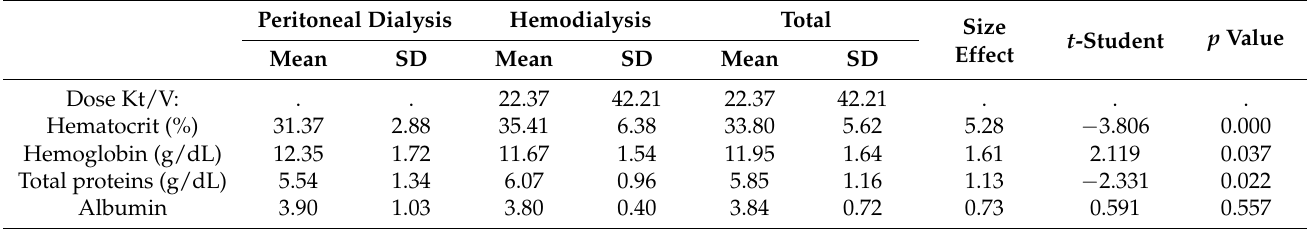
Table 1. Analytical parameters using the Mann-Whitney U Test.